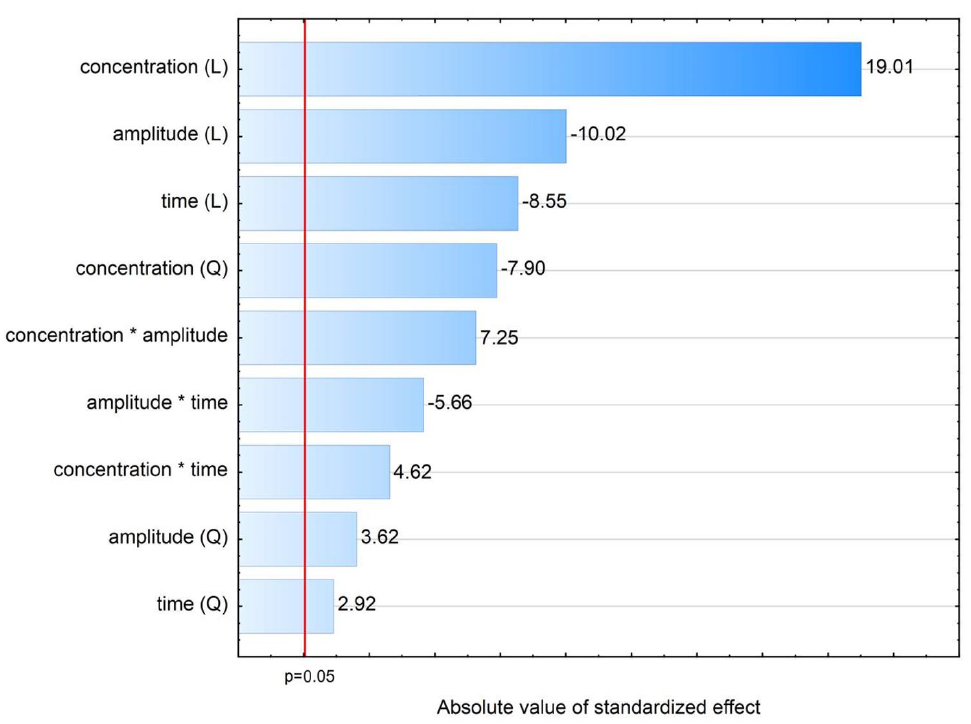
concentration was set at 10 mg/mL (Table 3, Figure A6A). Thus, these central composite design plan points were deliberately excluded from further analysis. This exclusion markedly improved regression coefficients (R 2 = 0.91, R 2 adj. = 0.89) and served as the ba- sis for further refinement, as normality of residuals still was not satisfied. Exclusion of Figure A5. Pareto chart of the standardized linear (L) and quadratic (Q) effect sizes of independent insignificant terms yielded the final model for d50 (Equation (4)) with acceptable distri- variables and their interactions in precipitation+sonication process studied according to central bution of residuals (Figure A6B). composite design plan. Bars above the red line denote statistically significant effects at p < 0.05.